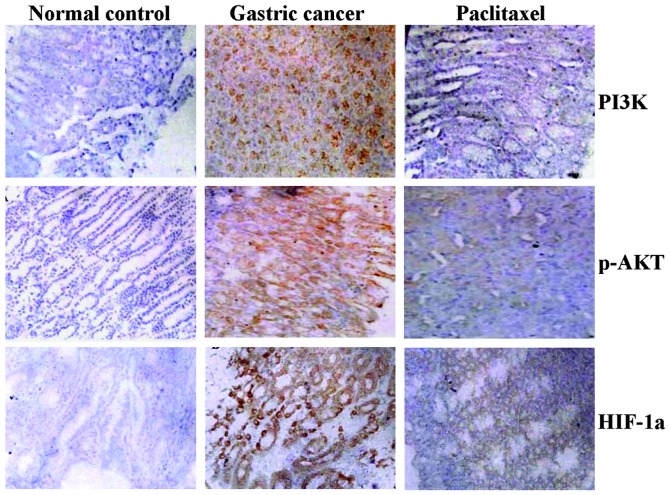
Effects of paclitaxel on the expression of PI3K, p-AKT and HIF-1α in vivo. The expression of PI3K, p-AKT and HIF-1α were assessed by immunohistochemistry in severe combined immune deficiency mice orthotopically implanted with human GC tissues and treated with paclitaxel. Paclitaxel decreased the expression of PI3K, p-AKT and HIF-1α compared with the GC and normal control groups. PI3K, phosphatidylinositol-3-kinase; p-AKT, phosphorylated-Akt; HIF-1α, hypoxia-inducible factor-1α.